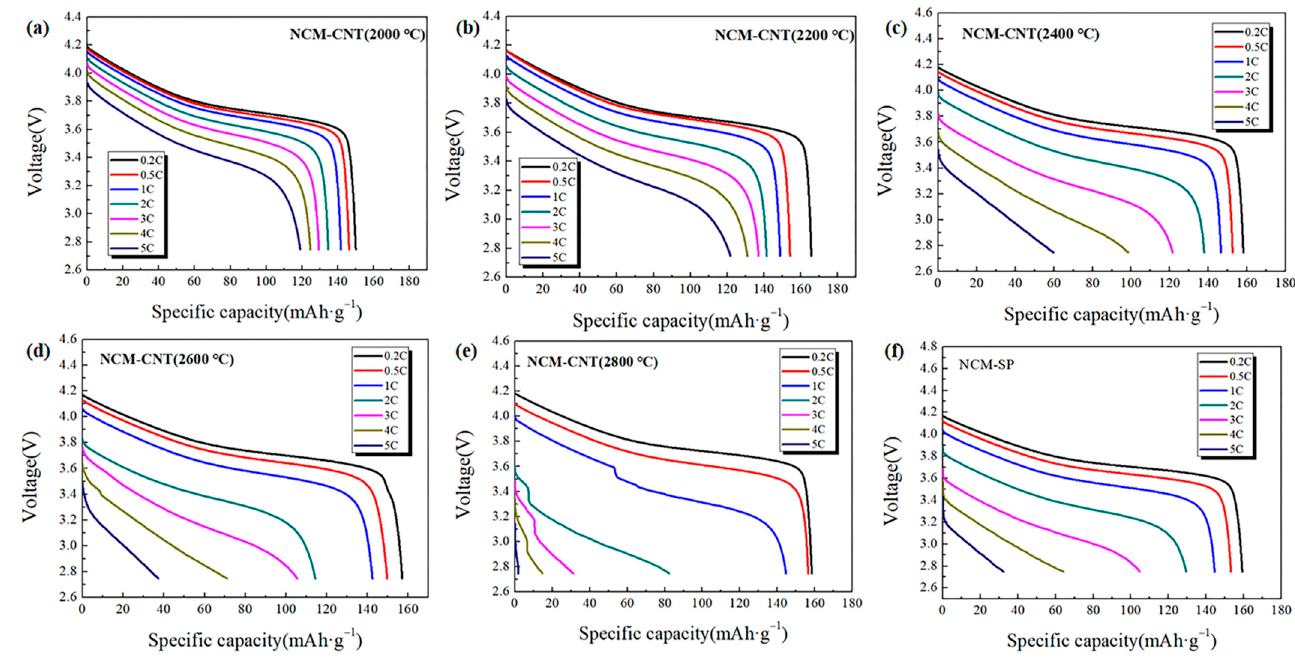
Figure 7. Initial discharge curves NCM-CNT (2000–2800 ◦ C) and NCM-SP batteries at different rates of all samples. ( a ) is the first discharge curve of CNM-CNT(2000 ◦ C) at different current rates; ( b ) is the first discharge curve of CNM-CNT(2200 ◦ C) at different current rates; ( c ) is the first discharge curve of CNM-CNT(2400 ◦ C) at different current rates; ( d ) is the first discharge curve of CNM-CNT(2600 ◦ C) at different current rates; ( e ) is the first discharge curve of CNM-CNT(2800 ◦ C) at different current rates; ( f ) is the first discharge curve of CNM-SP at different current